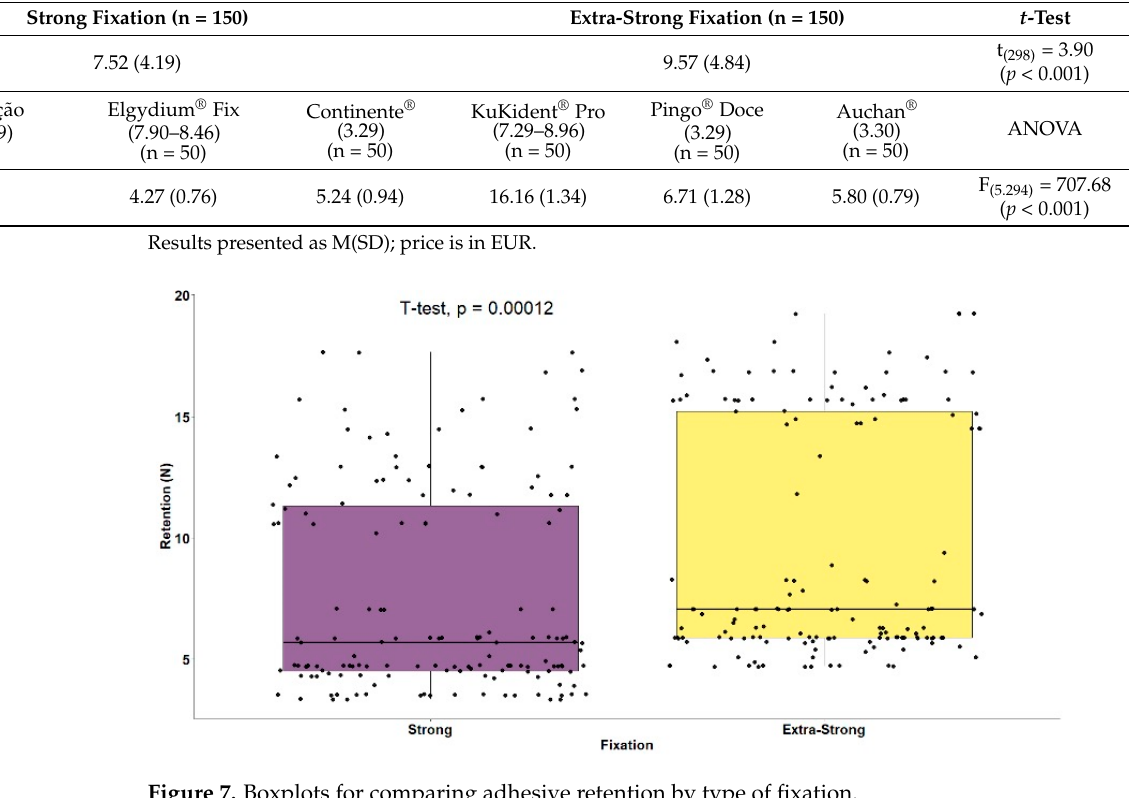
Figure 7. Boxplots for comparing adhesive retention by type of fixation.